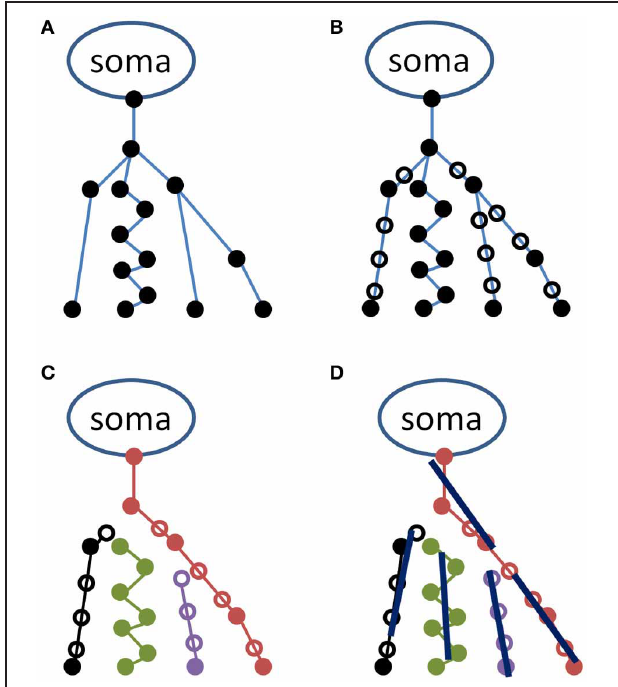
FIGURE 1 | Schematic representation of the procedure used in representing the neuronal tree by average lines. A hypothetical neuron is illustrated in the upper left panel (A) in the original NeuroMorpho format as a series of coordinates (filled circles) connected as indicated by blue lines. In the upper right (B) , additional points have been inserted (open circles) for making the distance between two points less than or equal to a minimal distance (herein, 1 μ m). In the lower left panel (C) , the neuron is represented as a set of unbranched paths, and in the lower right (D) , these are represented by average lines, each of length l .